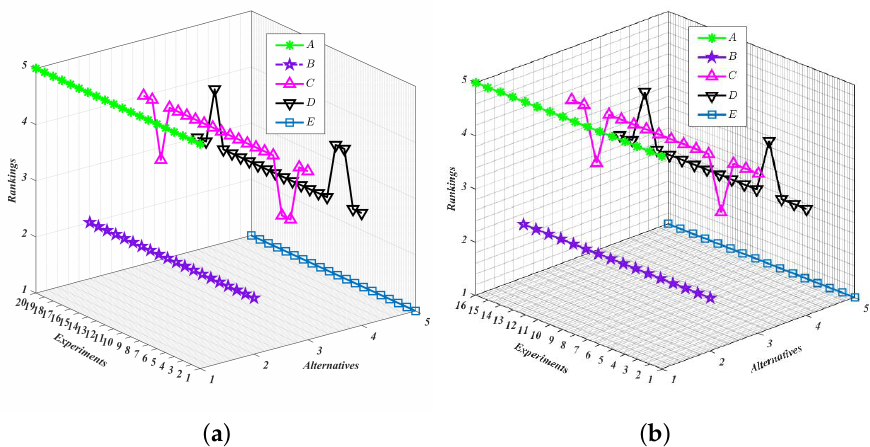
Figure 3. Weight variation and effect analysis: ( a ) weight variation and effect analysis on the final ranking of HazMat transportation alternatives to adjustments of the expert weights; and ( b ) weight variation and effect analysis on the final ranking of HazMat transportation alternatives to adjustments of the criteria